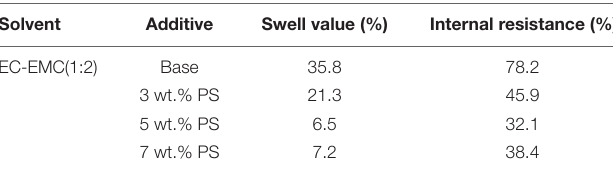
TABLE 2 | Conductivities of 1.0 M LiPF 6 – EC / EMC (1:2) at different content of PS. Electrolyte